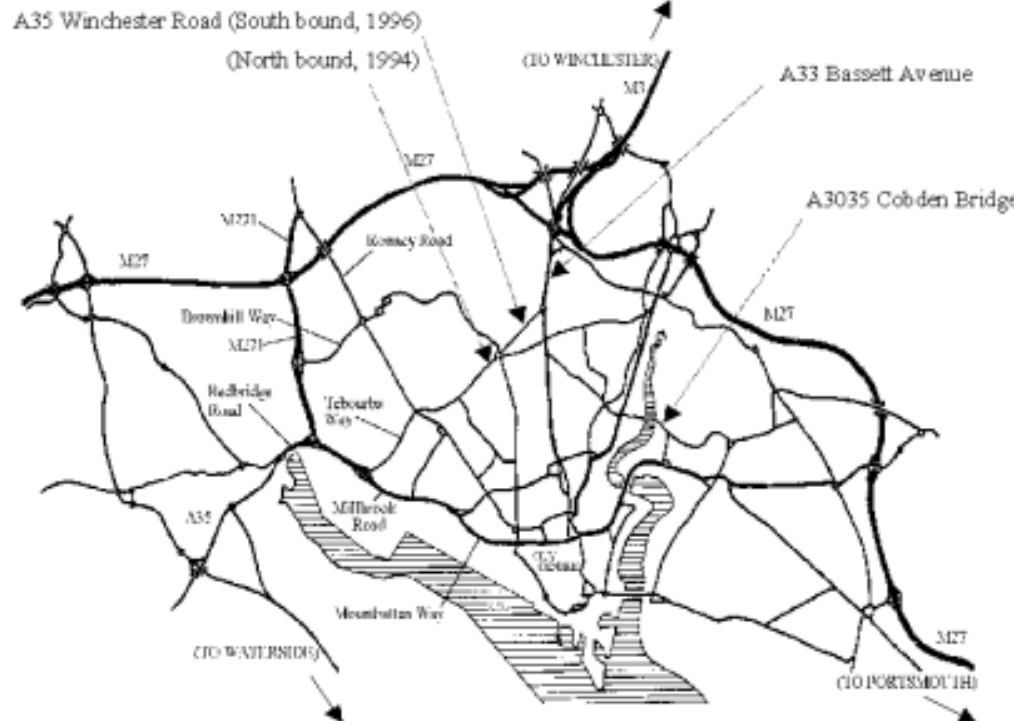
Figure 1. A map showing the key roads in and around the city of Southampton. Marked are the sites of the 1994 (A35 Winchester Road and A3035 Cobden Bridge) and 1996 (A33 Bassett Avenue and A35 Winchester Road) registration plate